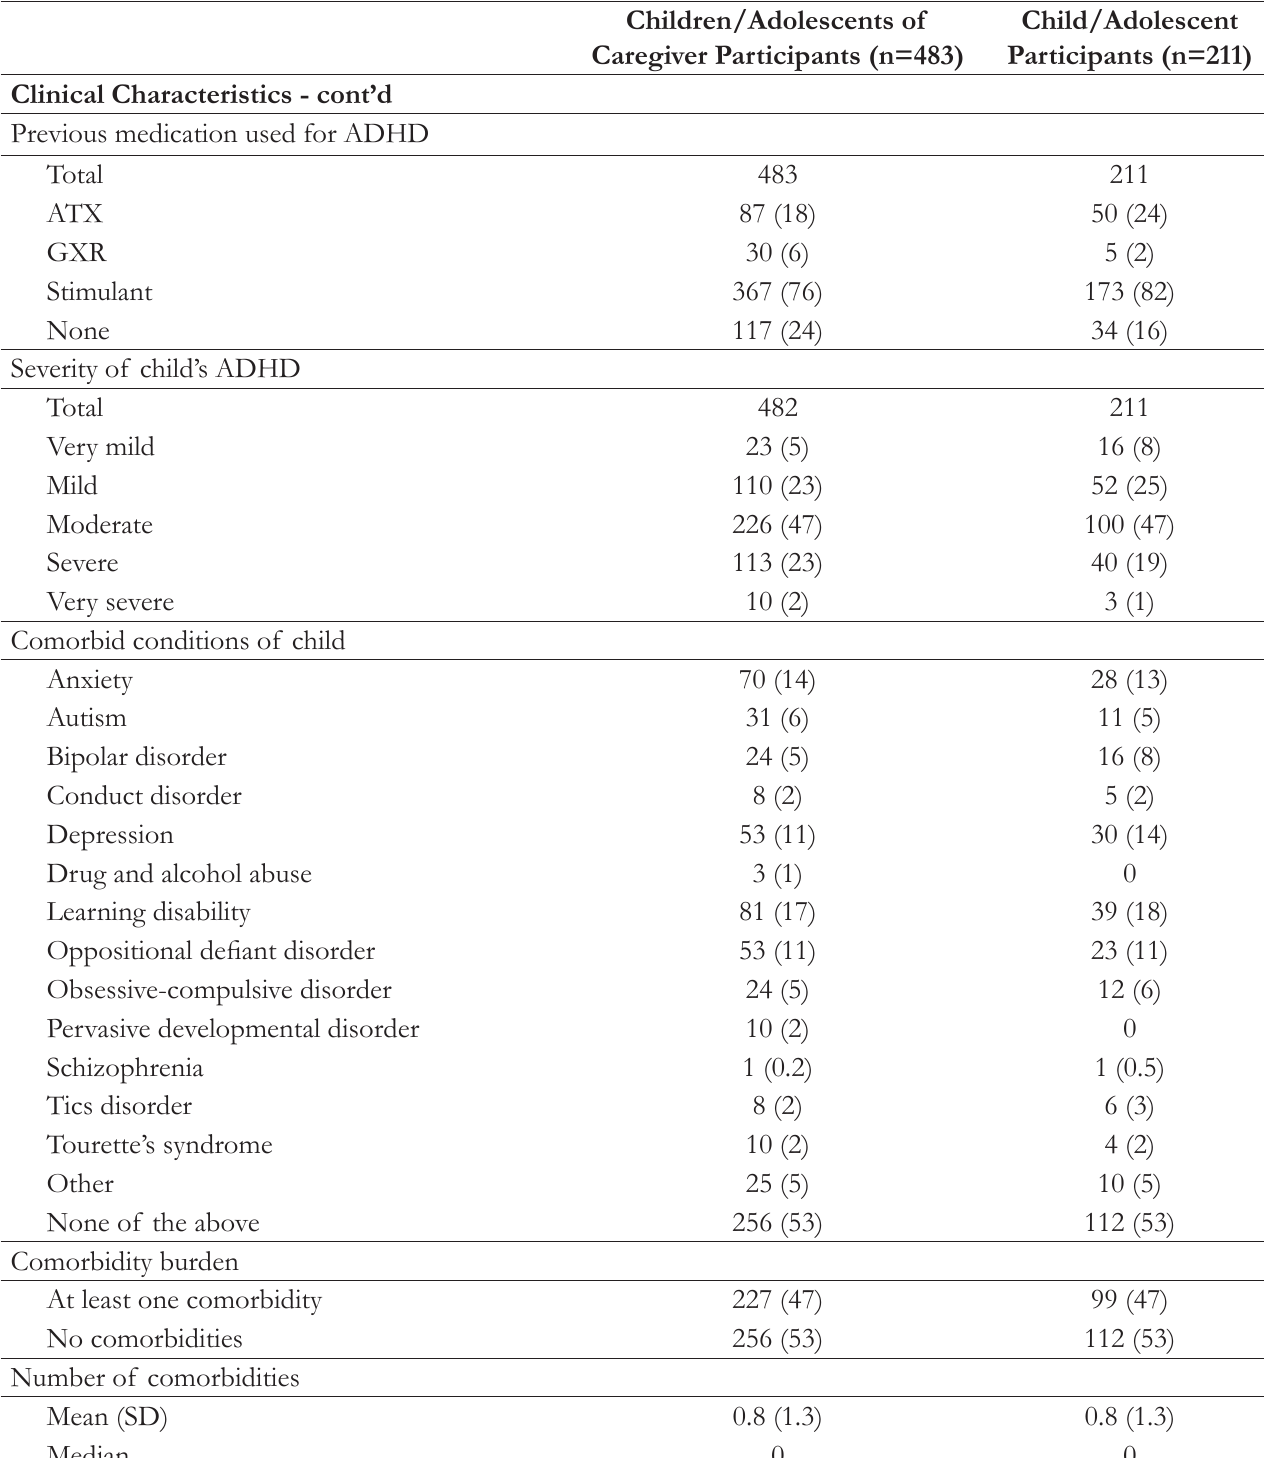
Table 2. Demographic and Clinical Characteristics of Child/Adolescent as Reported by Caregiver - cont’d